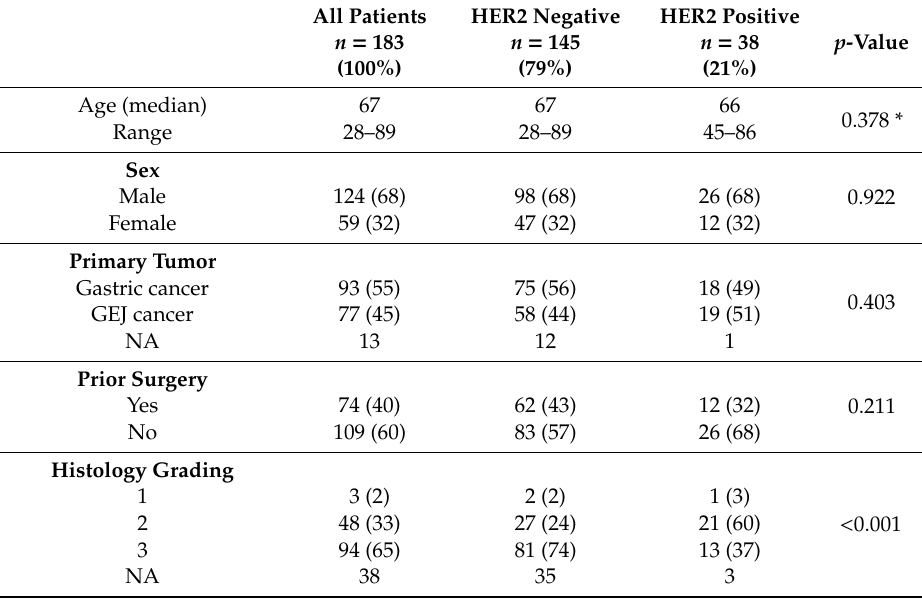
Table 1. Baseline characteristics according to central HER2 status.